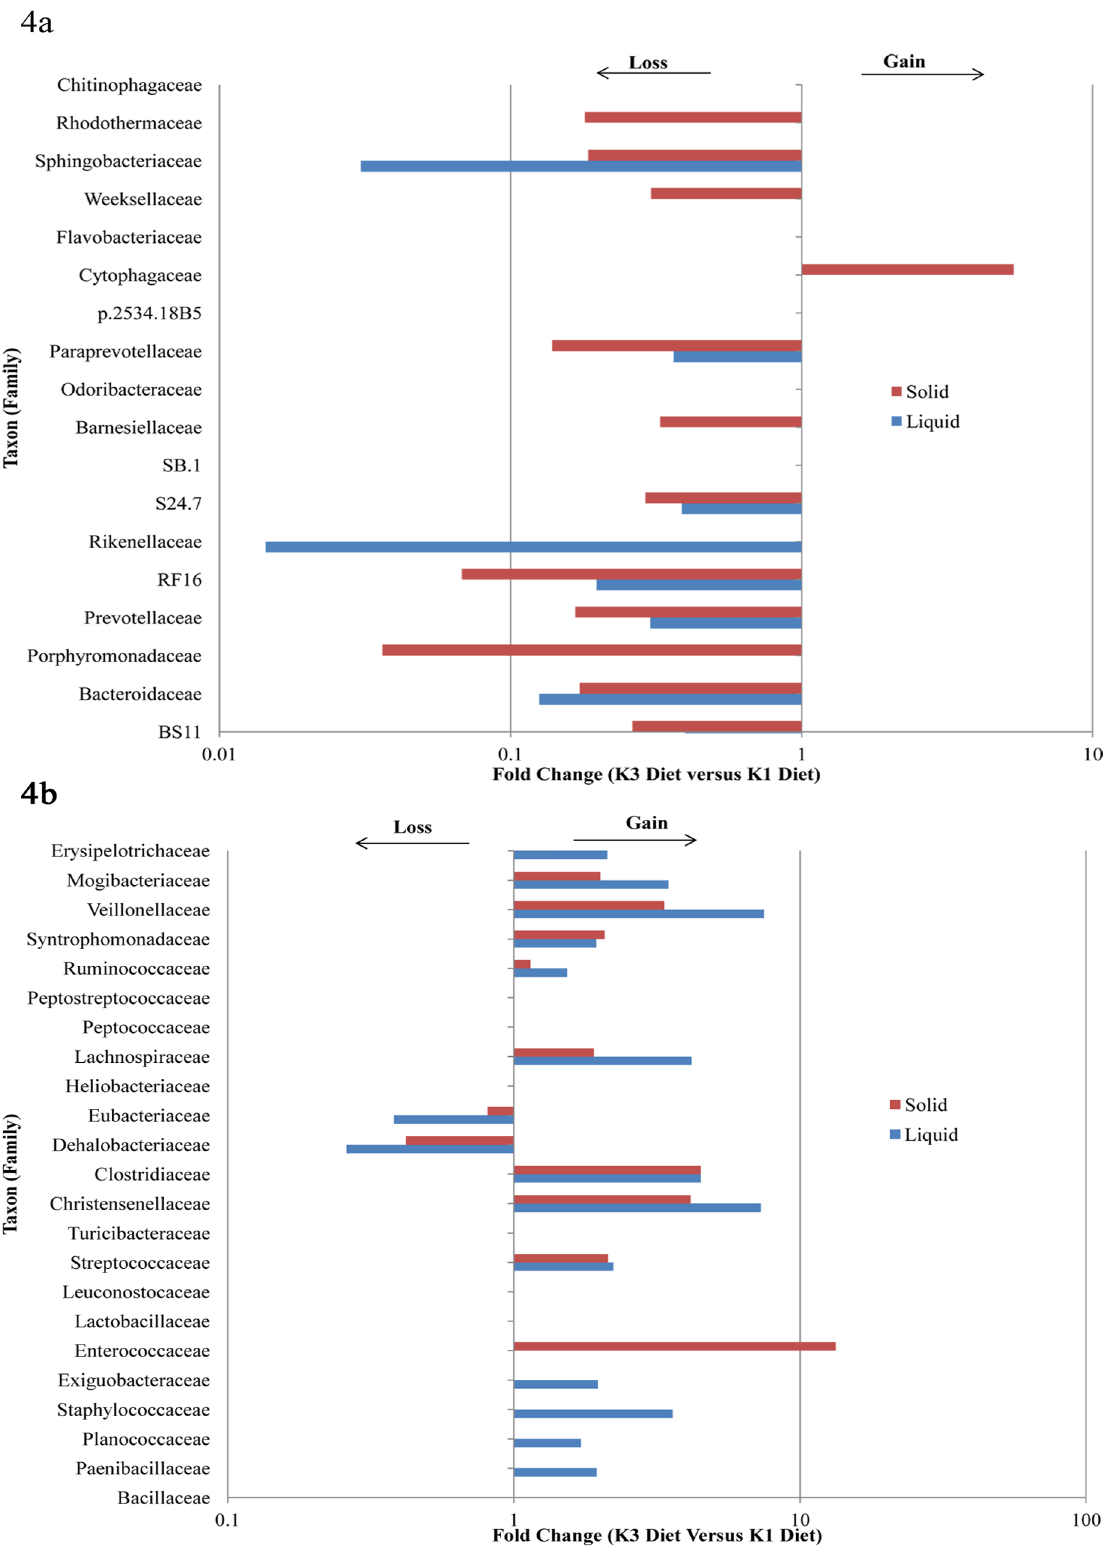
Figure 4. Fold changes in STabundant bacterial lineages at family level. Bacterial lineages a) loss of lineages in Bacteroidetes ; b) gain in lineages in Firmicutes , across both fractions and primers, as the animals transitioned from K1 (50% dry/green forage: 50% concentrate) to K3 (100% dry/green forage).